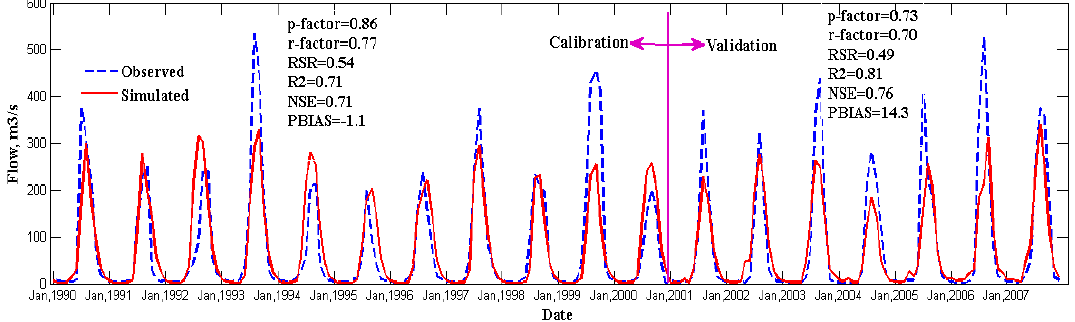
Figure 5. Calibration and validation of average monthly streamflow.